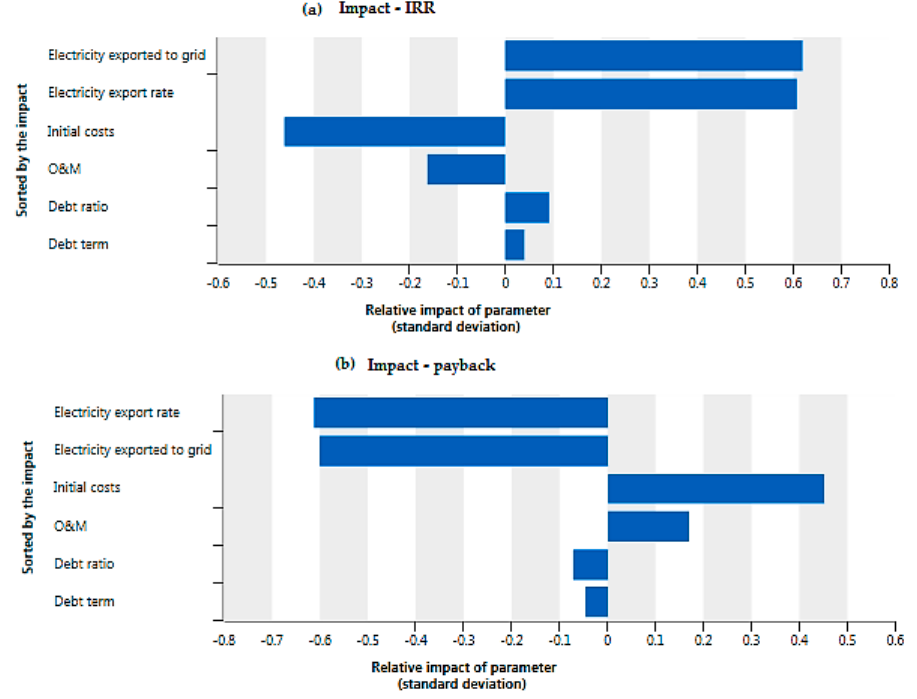
Figure 17. Risk impact; ( a ) IRR (%), ( b ) payback (year).